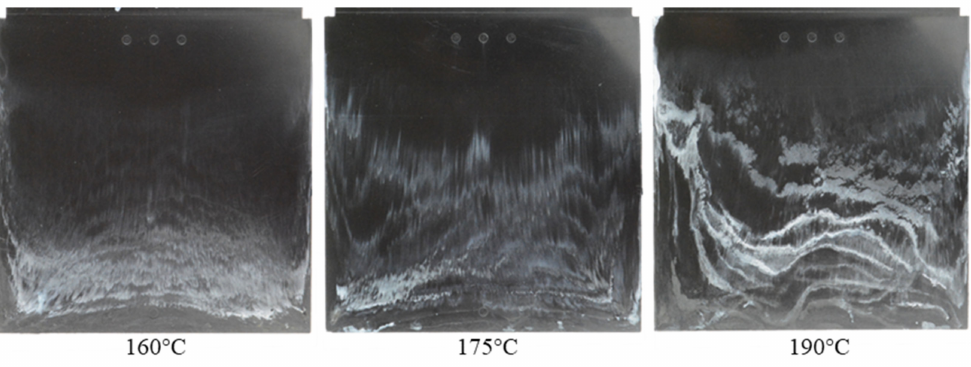
Figure 8. PF1110 (GF35+GB45); influence of mold temperatures on the slip